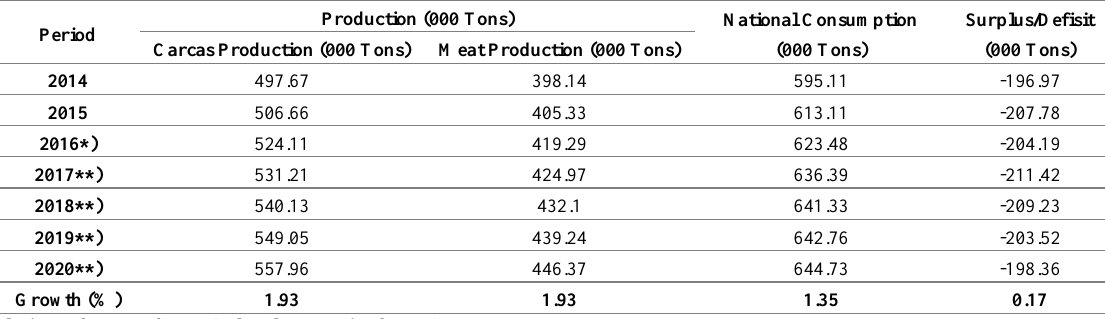
Table 1. Projection of surplus/deficit meat for period of 2014 – 2020